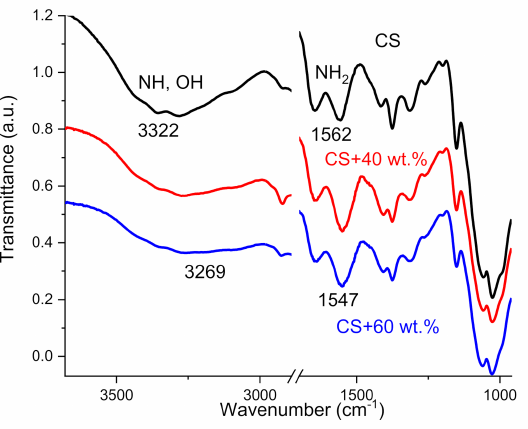
Figure 3. FTIR spectra of neat CS film and CS–TiO 2 films with 40 and 60 wt.% of NPs.